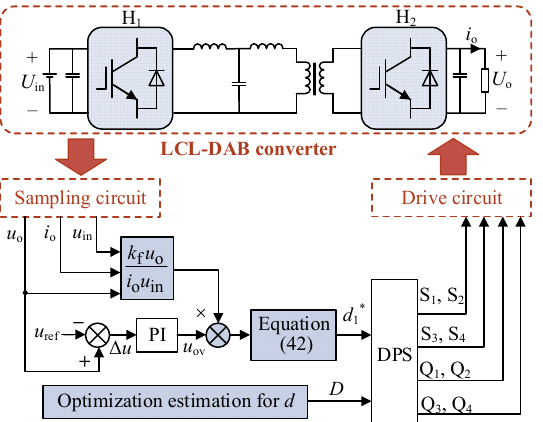
Figure 9. Schematic diagram of the proposed VDCC method for fast transient response and no backflow power.